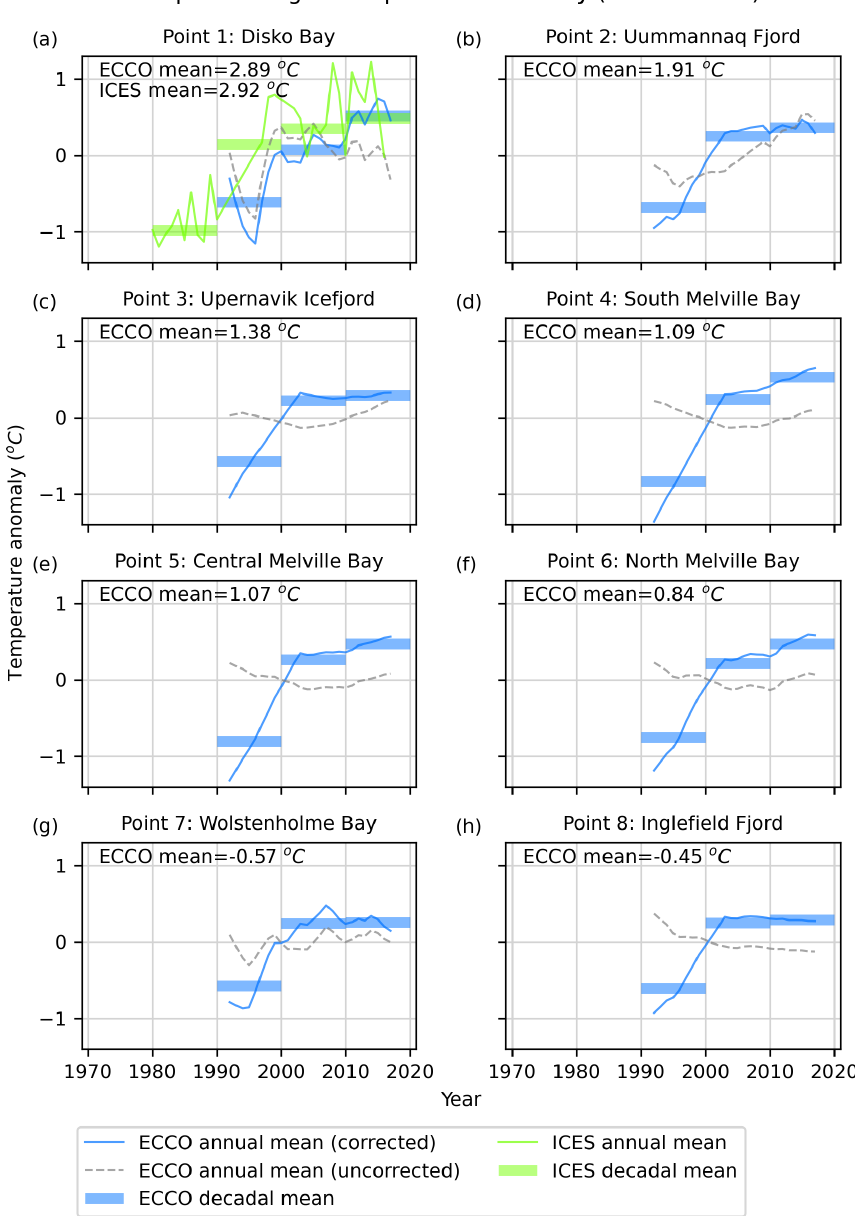
Figure 7. Annual and decadal mean deepwater (bottom 60%) ocean temperature anomaly from ECCO (blue) and ICES (green). Each panel corresponds with an ocean point in Fig. 1. The mean for each anomaly is reported in each panel. The “decadal” means are not taken over the entire decade in the 1990s (for ECCO) and 2010s due to lack of